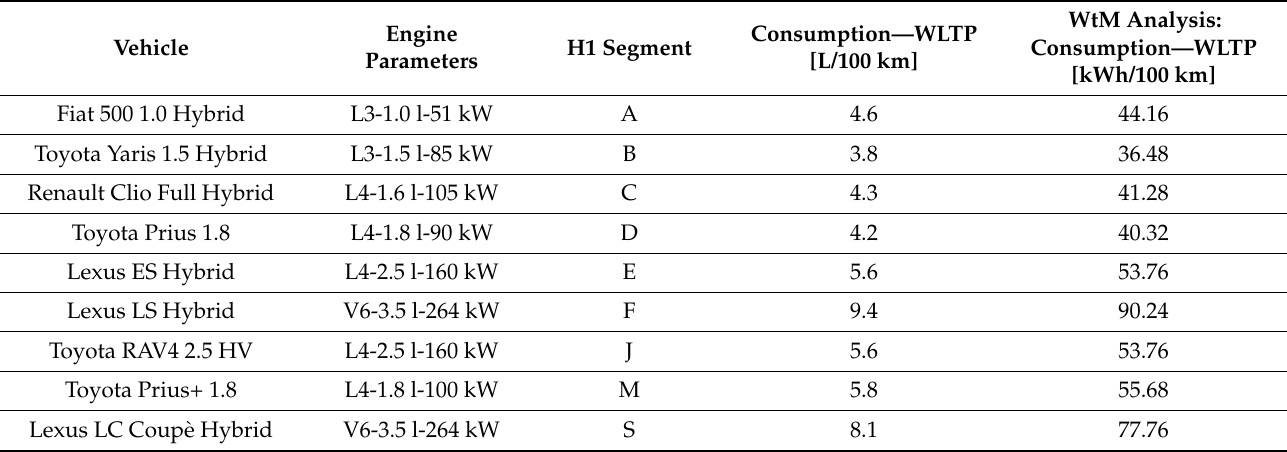
Table 8. Passenger vehicle fleet in Europe: division into powertrain and H1 segments—Powertrain: HEV [15,17,18].